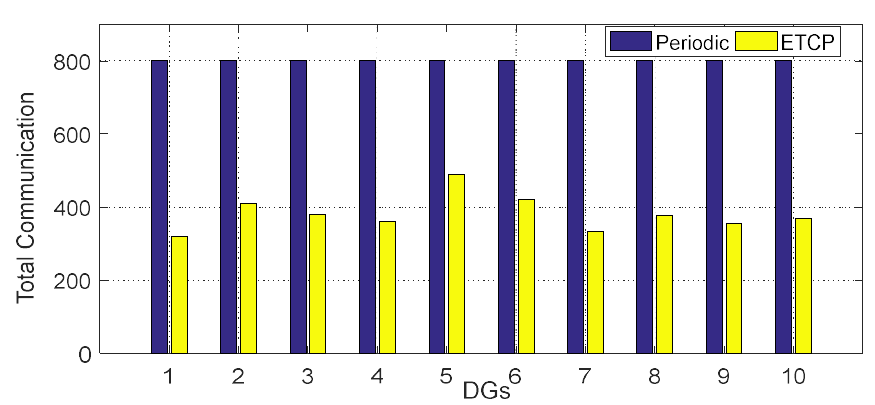
Figure 10. Total communication of ETCP and periodic communication.